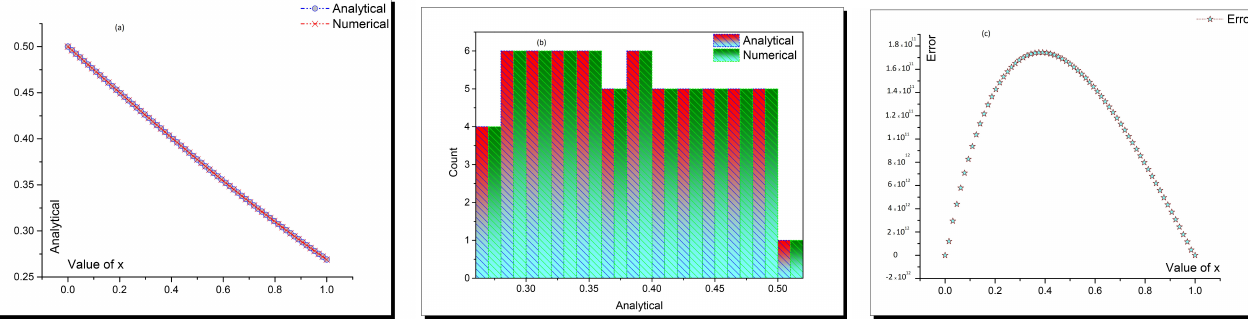
Figure 6. Two-dimensional plot ( a ) and double y-column plot ( b ) for the matching between obtained analytical and numerical solutions, and two-dimensional plot of the absolute error ( c ) for Equation (3) with respect to Table